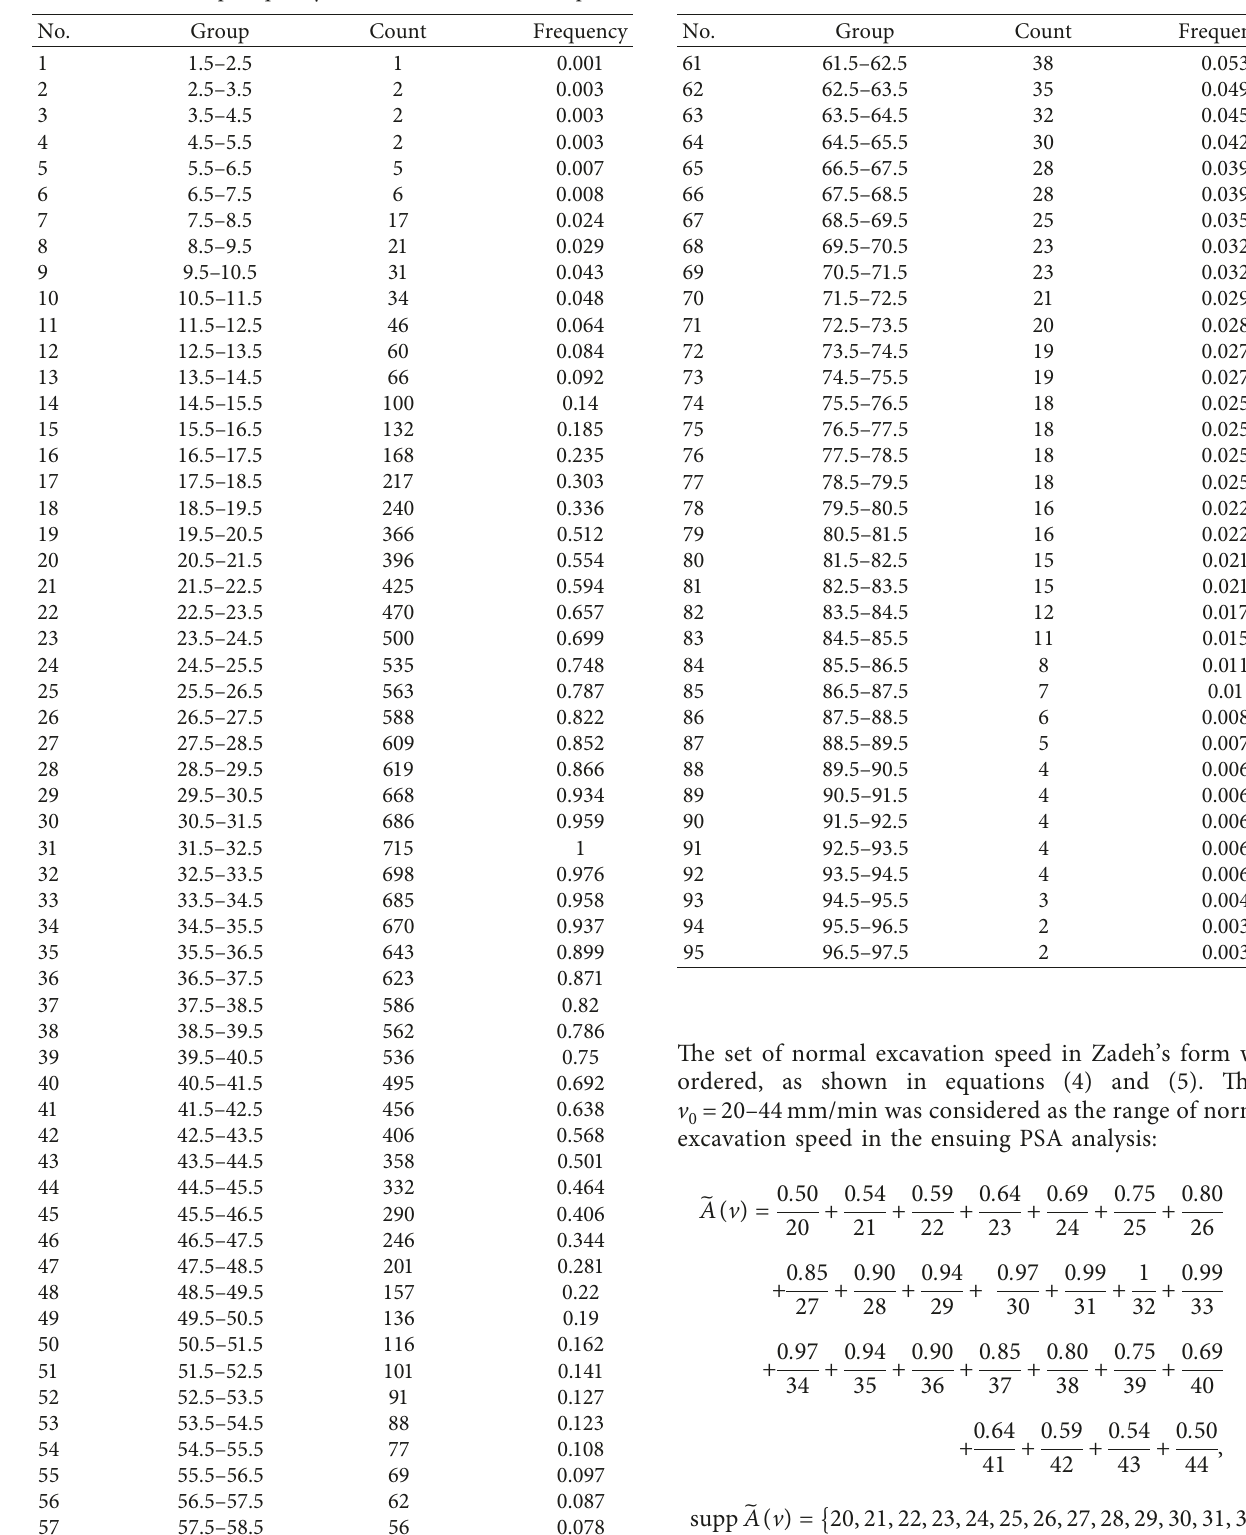
Table 5: Membership frequency of the “normal excavation